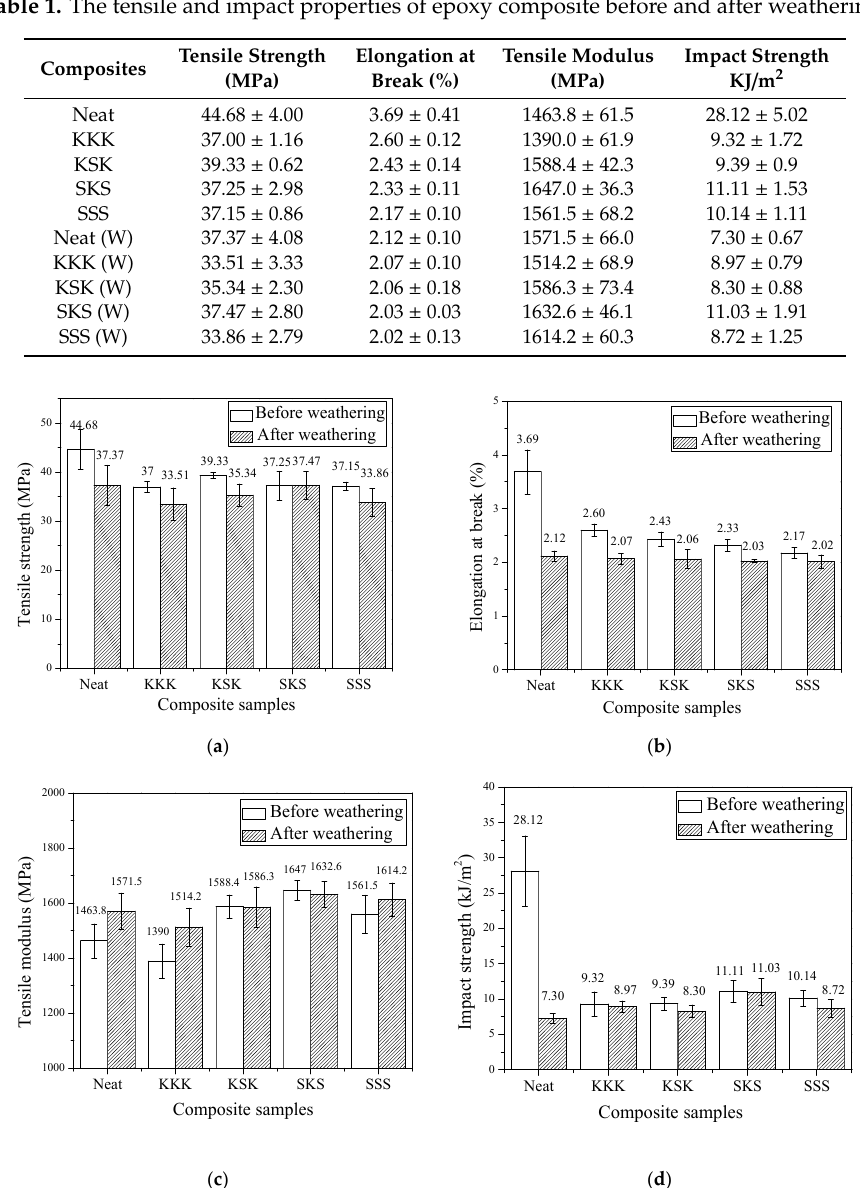
Figure 3. The ( a ) tensile strength, ( b ) elongation at break, ( c ) tensile modulus, and ( d ) impact strength of epoxy composite before and after weathering.